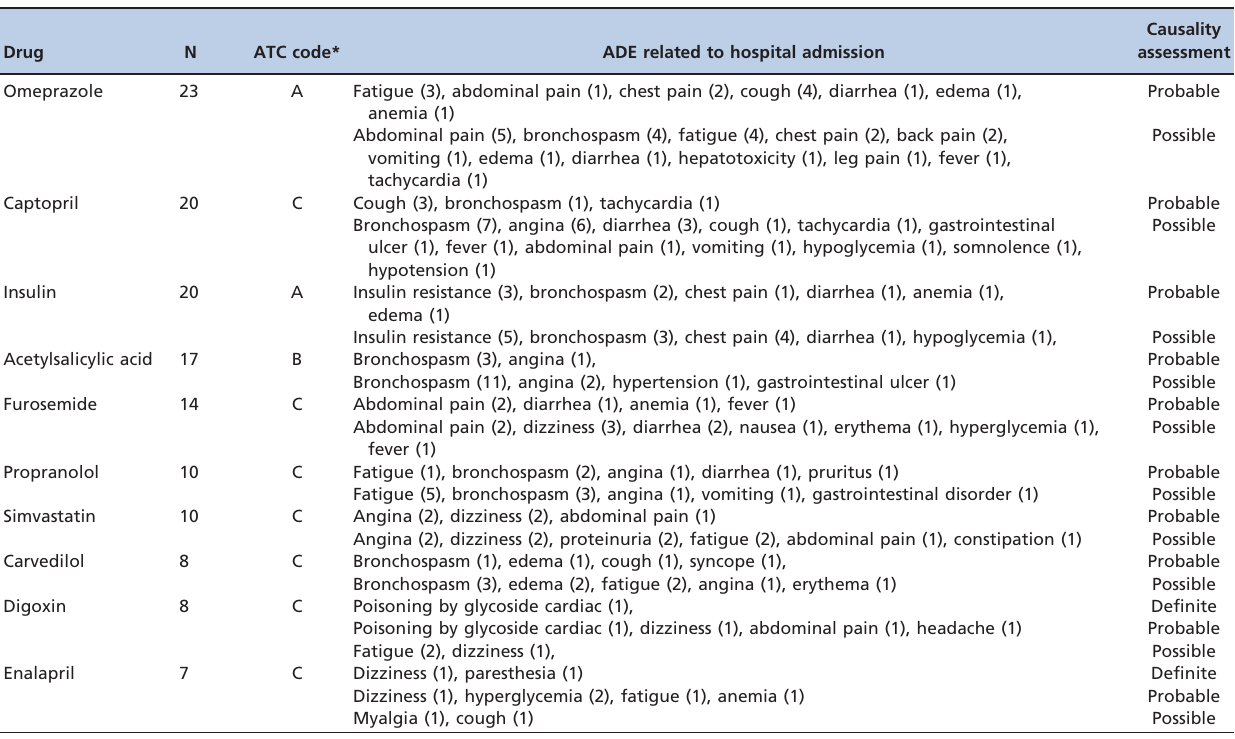
Table 2 - Frequency of the 10 drugs most commonly taken by patients prior to admission to the internal medicine ward, as reported at hospital admission, along with their ATC codes, the ADEs identified, and an assessment of causality using the Naranjo algorithm.